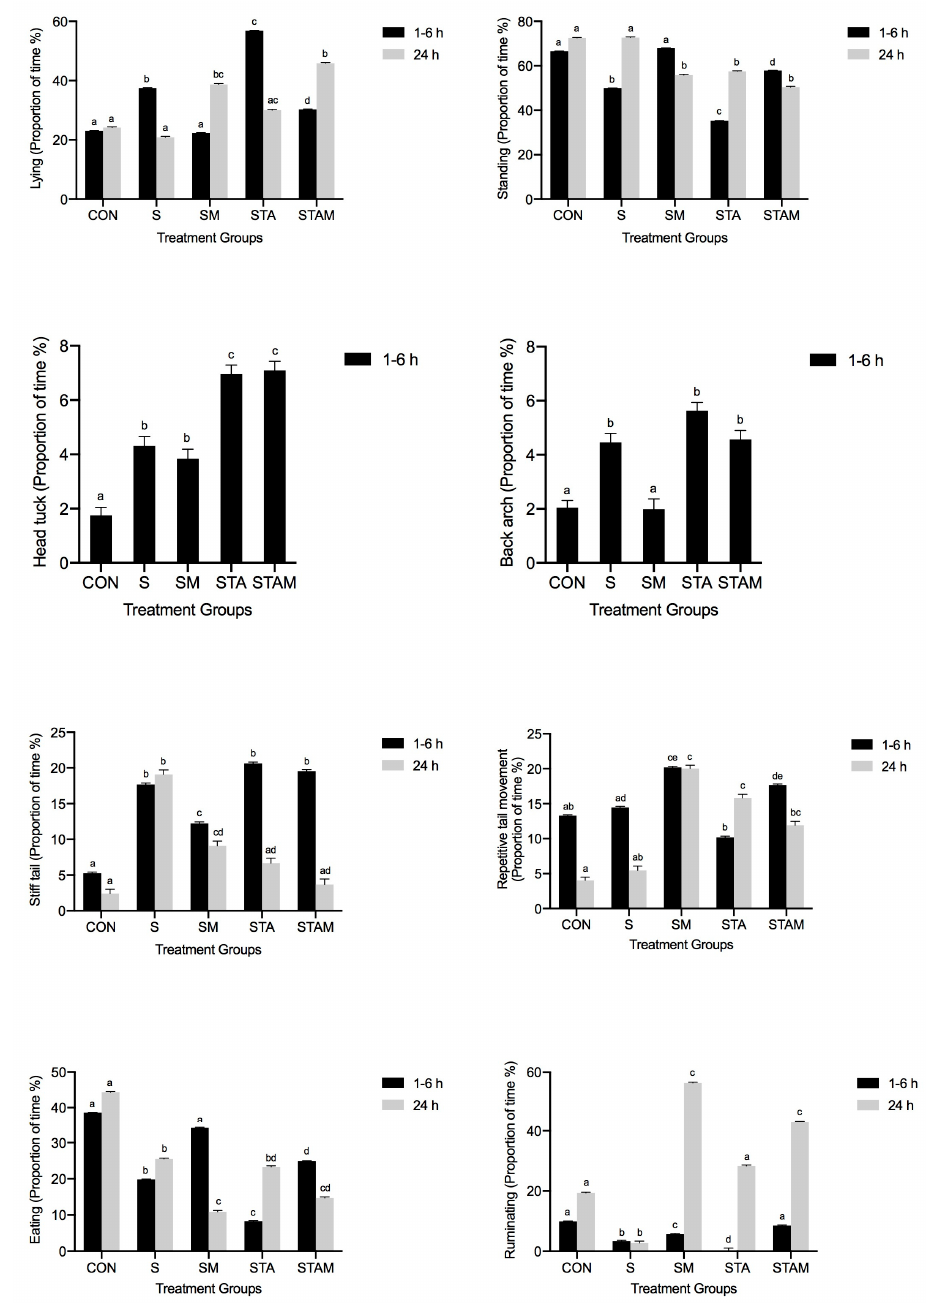
Figure 3. Comparison of select behaviours exhibited by heifers at 1–6 h and 24 h post-procedure after rectal palpation (CON) or after spaying with the Willis dropped ovary technique without anaesthesia or analgesia (S), with intra-operative delivery of meloxicam (SM), a topical anaesthetic (STA), or a combination of both treatments (STAM). Columns with different letters for the 1–6 h and 24 h timepoints are significantly different ( p ≤ 0.05).